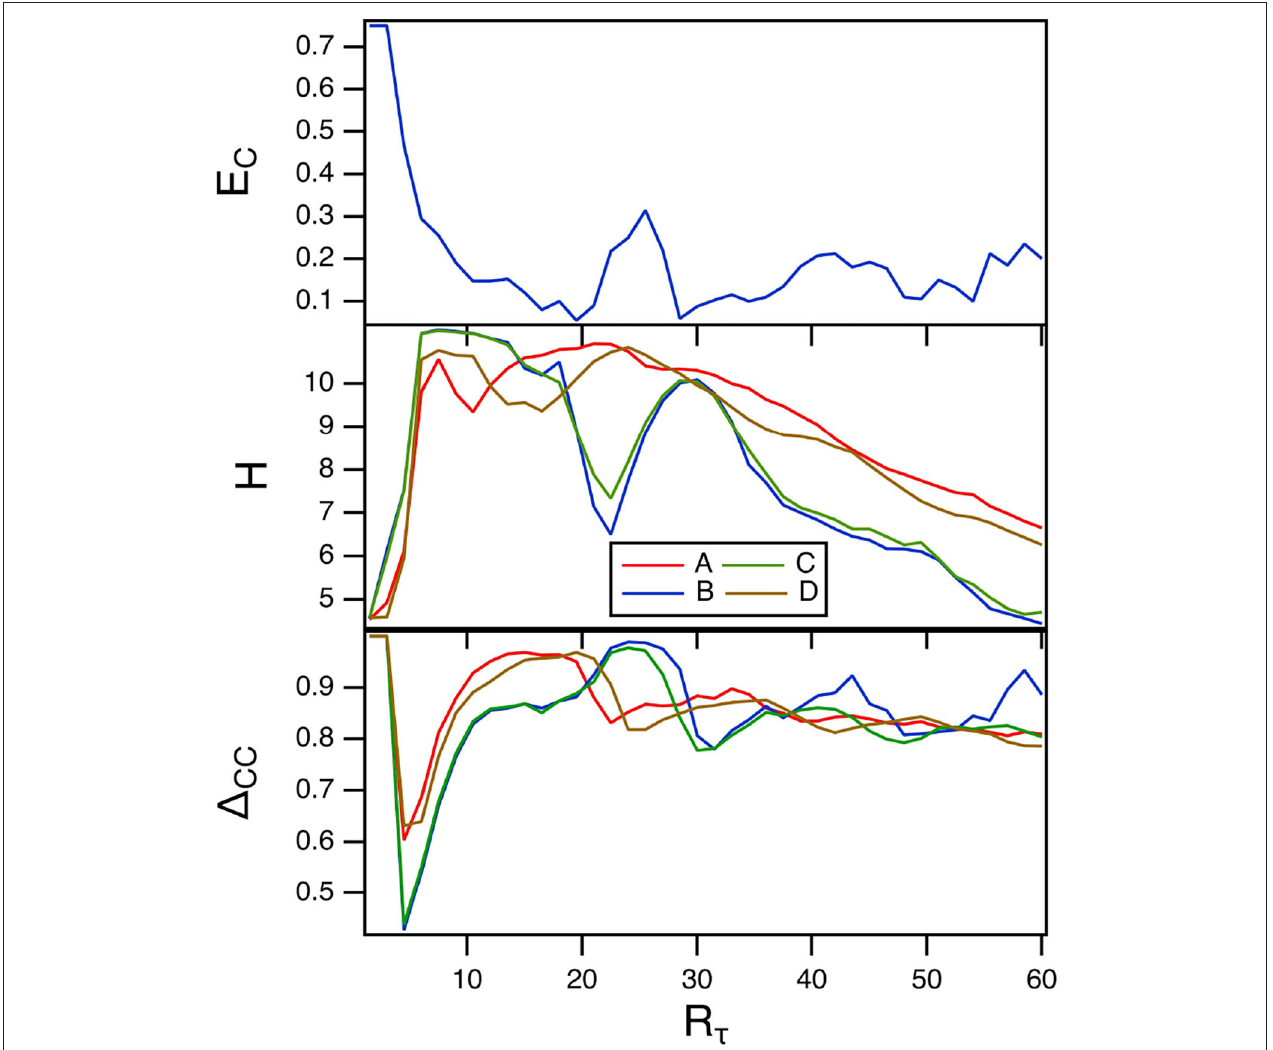
FIGURE 4 | The top plot shows the fraction of errors E C in identifying which of the four Sprott systems was present, as a function of the fast to slow time ratio R τ for the spiking reservoir computer. The middle plot shows the entropies for the four Sprott systems over the same parameter range. The bottom plot is the training error 1 CC . For this plot, γ = 0.004 and R τ =